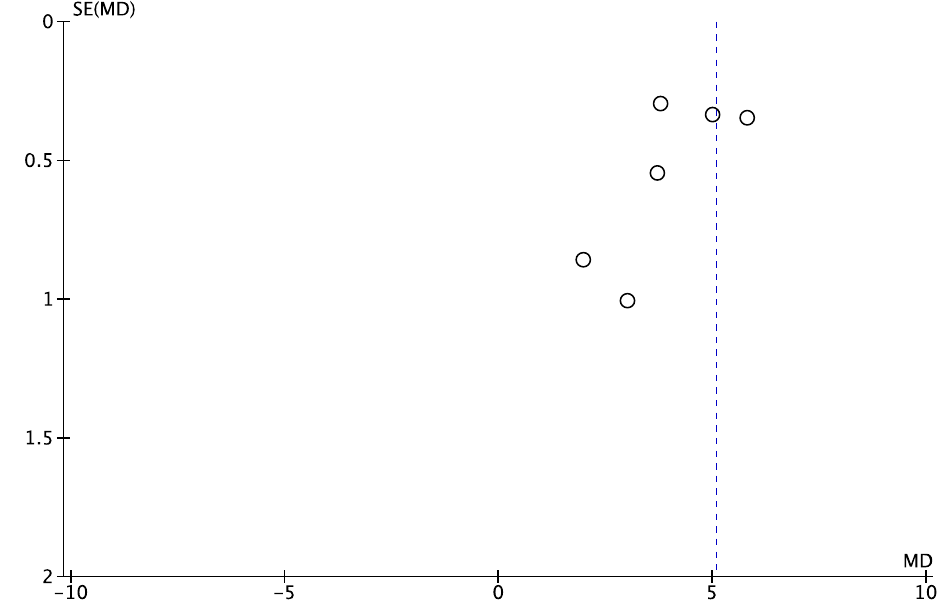
Figure 5. Funnel plot of comparison: VAS, outcome in PCR-BT. SE: Standard Error; MD: Mean Difference.